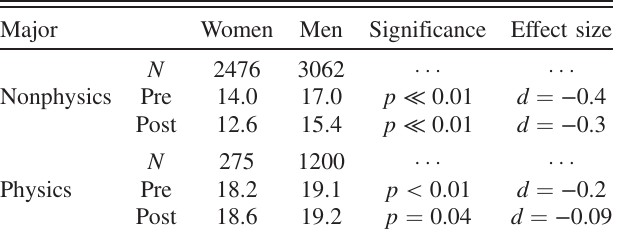
TABLE VII. Overall E-CLASS scores (points) for men and women on both the pre- and post-tests for the physics and nonphysics student populations separately. Significance indicates the statistical significance of the difference between women ’ s and men ’ s scores.